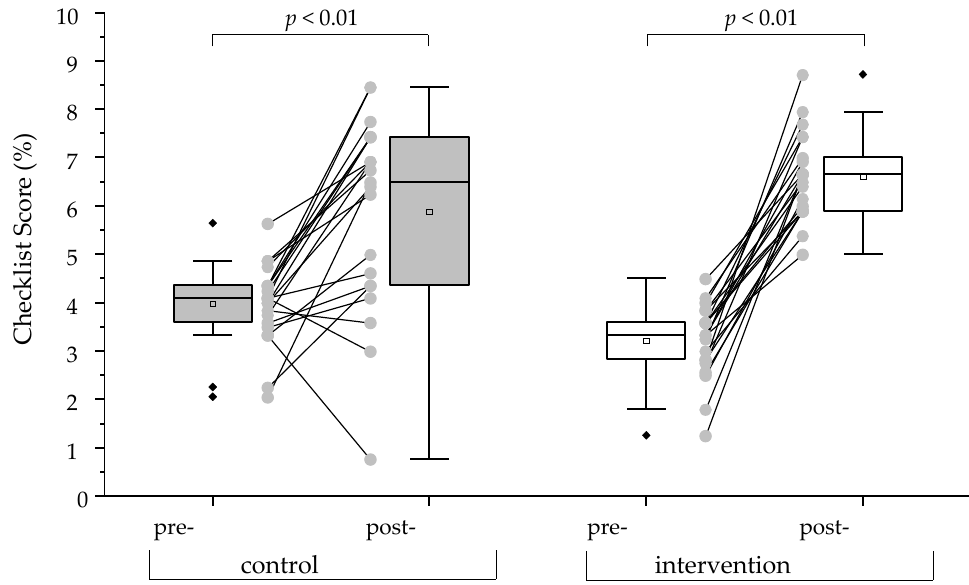
Figure 4. Box plots of analytical Checklist scores between pre- and post-Training OSCEs. The grey dots and lines show the difference in performance of each participant. The black diamonds ( ♦ ) indicate the outliers. A one-sided paired Wilcoxon signed-rank test with a significance level of alpha = 0.05 was used to compare OSCE scores between pre- and post-Training of the respective groups.